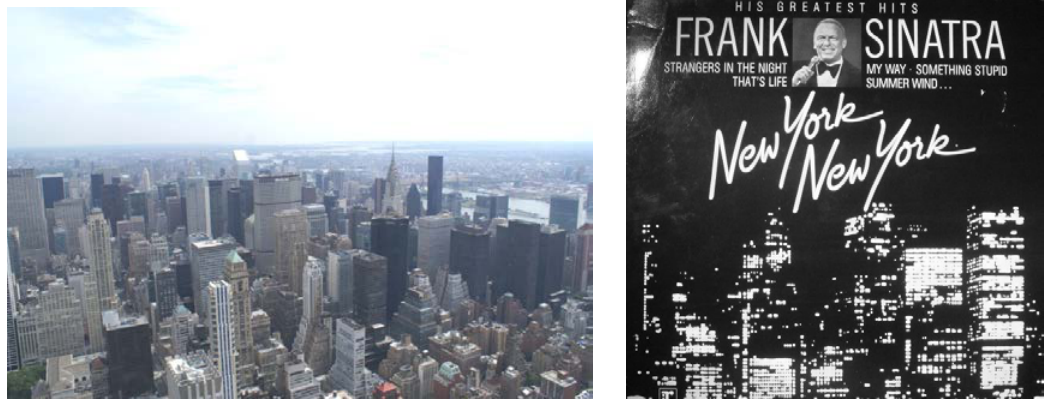
Figure 11: (left) Skyscrapers or the ‘concrete jungle’ of New York; (right) The lights of New York designed on the front cover of Sinatra’s